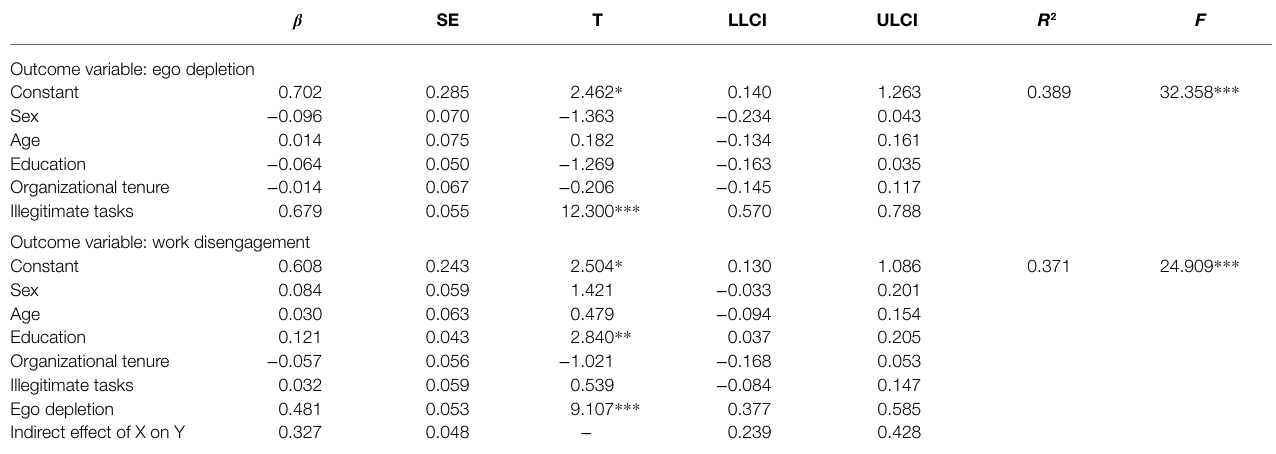
TABLE 4 | Results for mediating effect analysis.